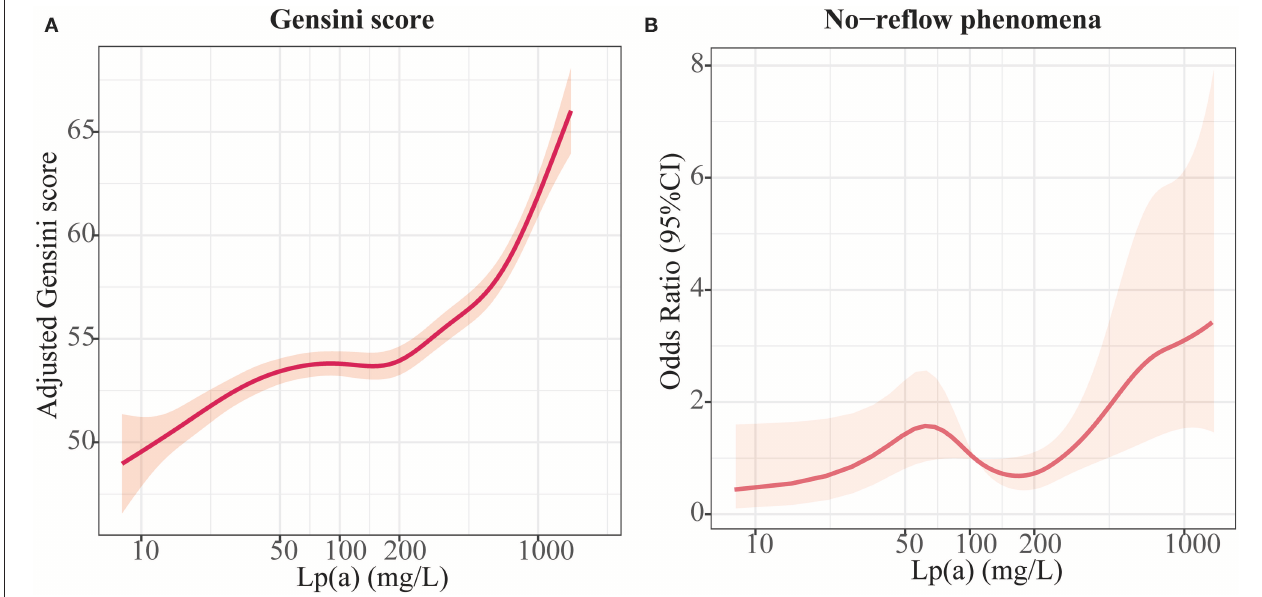
FIGURE 2 | Relationships between lipoprotein (a) [Lp(a)] and atherosclerotic burden. (A) Association of Lp(a) with Gensini scores in an adjusted model; (B) Association of Lp(a) with no-reflow in an adjusted model.